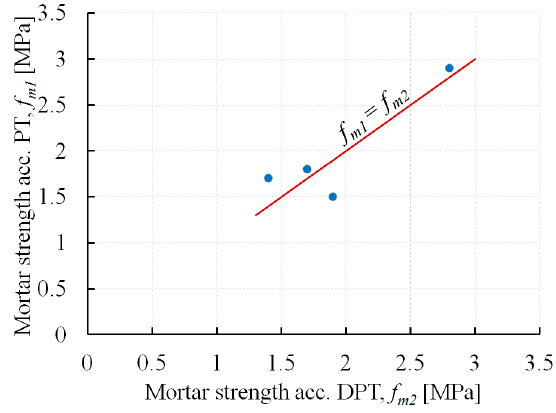
Figure10. Thecomparisonofthemortarcompressivestrengthvaluesdeterminedbasedonpenetrometer Figure 10. The comparison of the mortar compressive strength values determined based on tests ( f m 1 ) and double punch tests ( f m 2 penetrometer tests ( f m1 ) and double punch tests ( f m2 ).